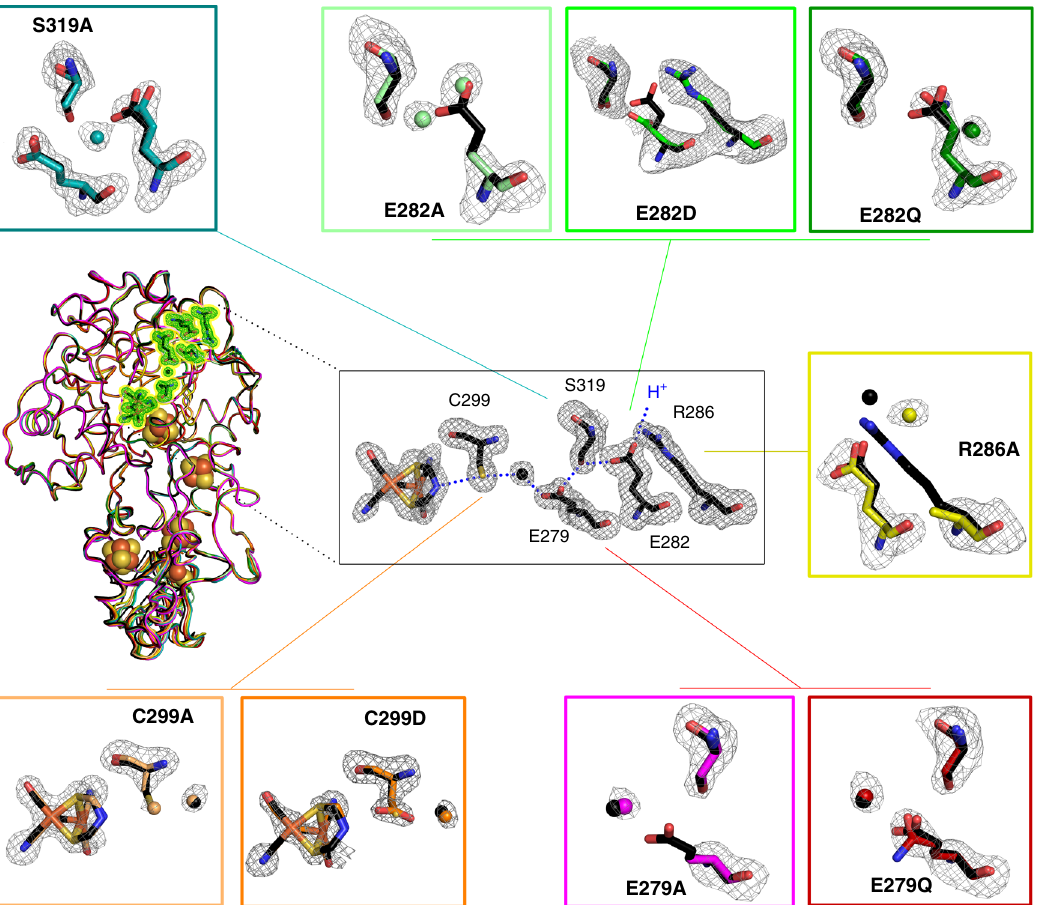
Fig. 4 Structural features of SDM variants targeting the putative PT pathway in CpI. Structures of nine SDM variants are superimposed as cartoon-loop models together with the 4XDC 19 wild-type structure. No unspeci fi c differences are observed. For each variant an enlargement of its electron density map in the putative PT pathway and the corresponding sticks model has been aligned with the structure of wild-type protein (H 2 O molecules and carbon atoms colored in black). For the CpI proteins local structural differences near the site of mutagenesis are depicted (for the HydA1 variants see Supplementary Fig. 5). Simulated annealing omitting maps ( F o − F c ) were contoured at 3 σ except for E282D, which was contoured at 1.9 σ due to its comparatively